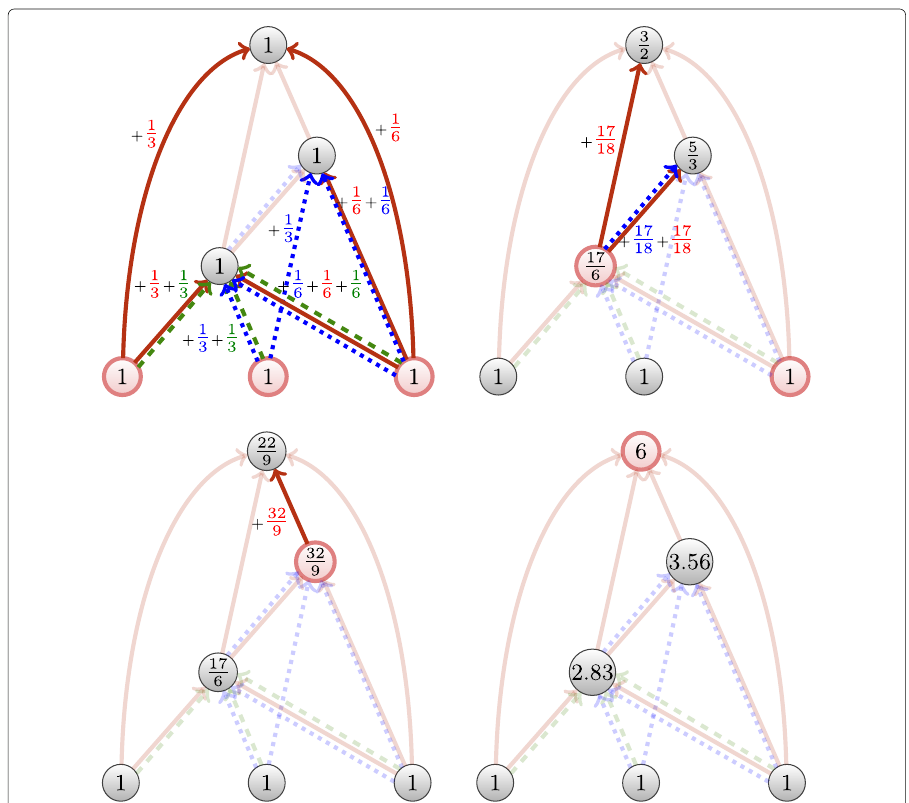
Fig. 9 Aggregated flow in a multiplex network, step by